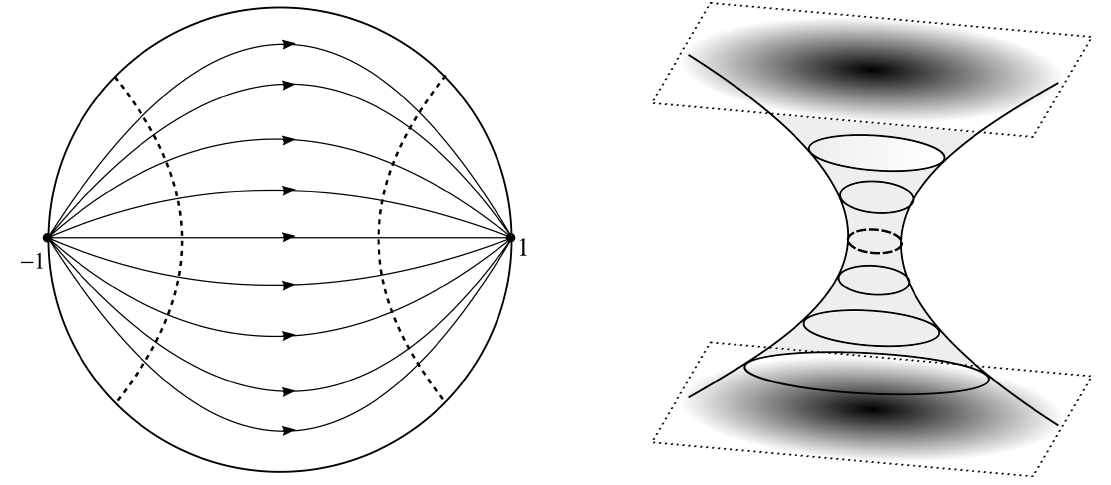
Figure 2 . A reproduction of a figure in [27]. The image on the left represents the fundamental domain of H / Γ . The flow lines connecting the points 1, -1 are the curves that are mapped onto itself by the hyperbolic generator. The dashed lines cut all the flow exactly once and perpendicularly, they are mapped onto each other by the hyperbolic generator. It is these dashed lines that are identified. The right image shows an embedding of the left fundamental domain in three-dimensional space. Due to the metric of H this takes the form of a hyperboloid. The dashed line represents the non- contractible cycle of minimal length, its length A is given by A = log λ